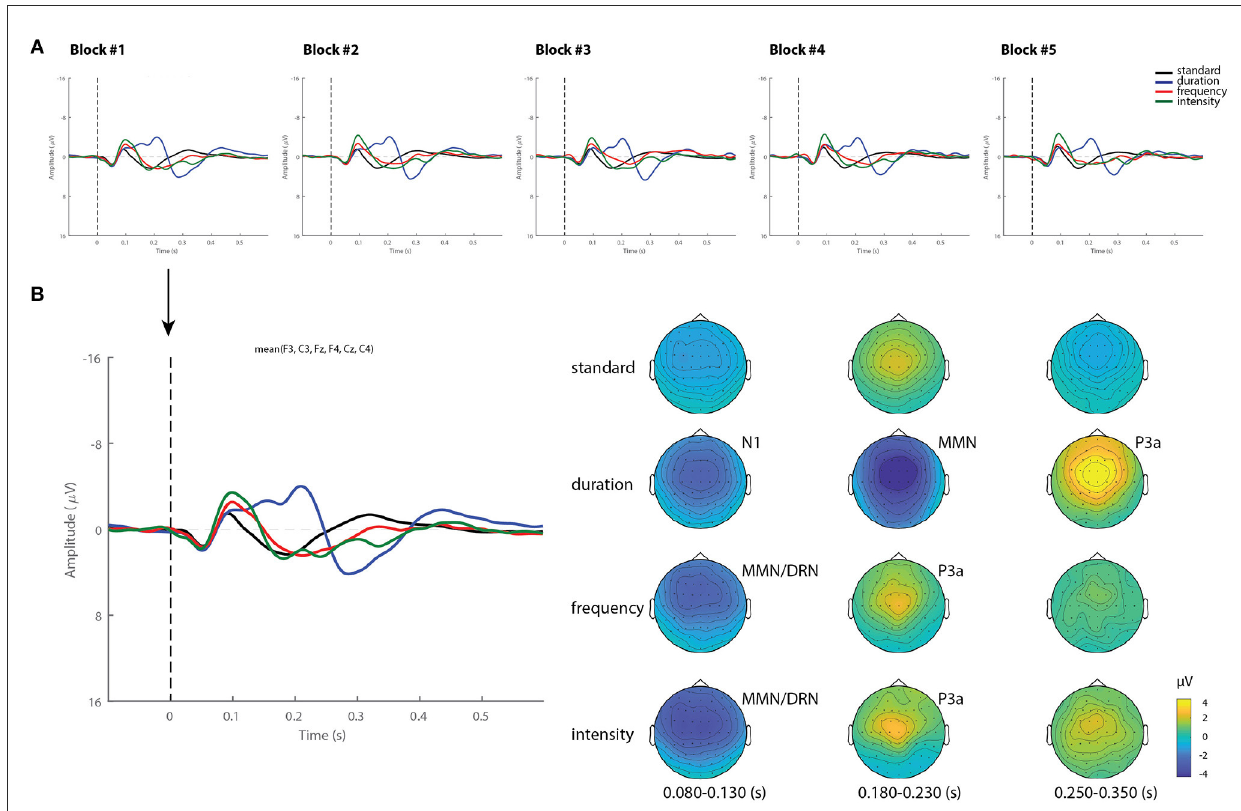
FIGURE1 Grand-average ERPs and topography in healthy controls. (A) Grand-average ERP for each stimuli (standard, duration, frequency, and intensity) across blocks. (B) Example of ERP waveforms and scalp topographical maps of Block 1 averaged over 80–130, 180–230, and 250–350 ms time intervals.